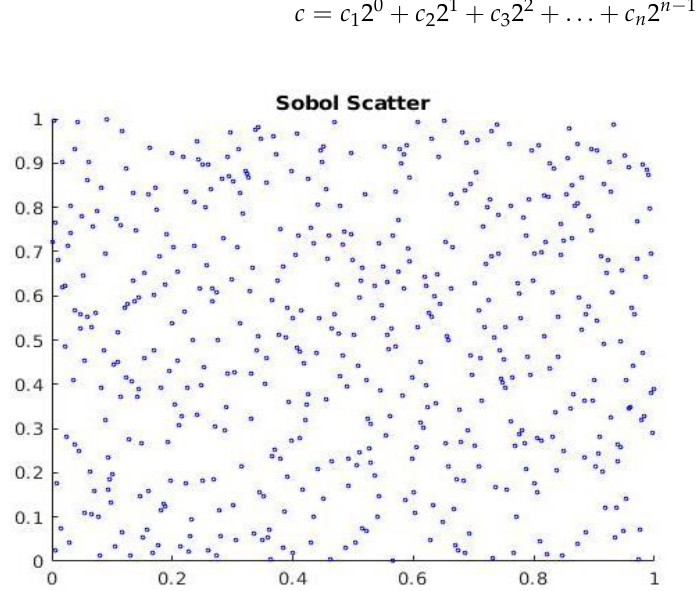
Figure 2. Sample points generated using Sobol distribution.